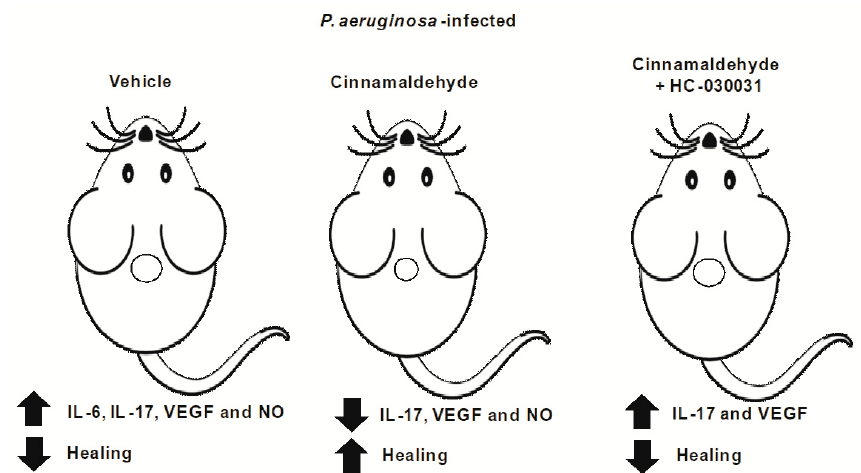
Figure 6. Summary of cinnamaldehyde effects in the wound healing of mice infected with P. aeruginosa . Mice infected with P. aeruginosa have delayed healing, associated with increased production of inflammatory mediators in the wound beds in response to this bacterial infection. The topical application of cinnamaldehyde reduces the bacterial load in the wound tissue and promotes wound healing, as denoted by reduction of the wounded area. This effect is associated with diminished levels of IL ‐ 17, VEGF and NO in the wound beds. The systemic TRPA1 antagonism by HC ‐ 030031 prevents cinnamaldehyde’s pro ‐ healing action by increasing IL ‐ 17 and NO levels.